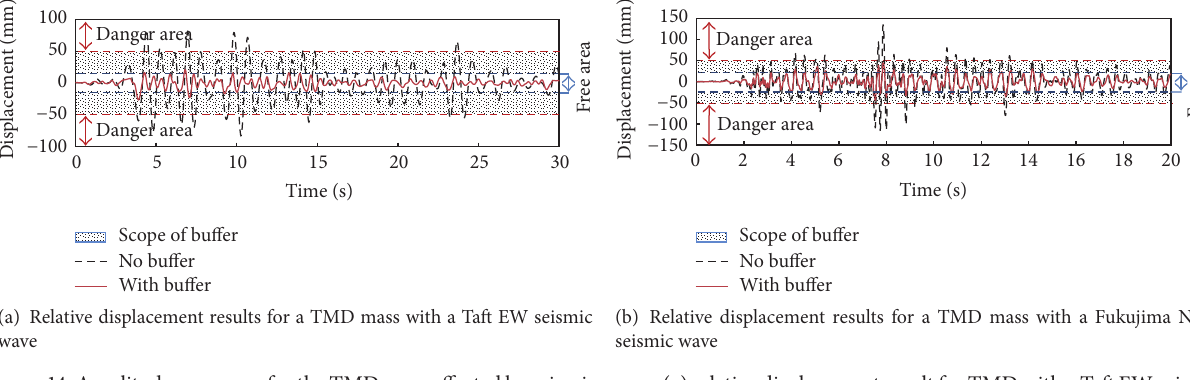
Figure 14: Amplitude responses for the TMD mass affected by seismic waves: (a) relative displacement result for TMD with a Taft EW seismic wave and (b) relative displacement result for the TMD with a Fukujima NS seismic